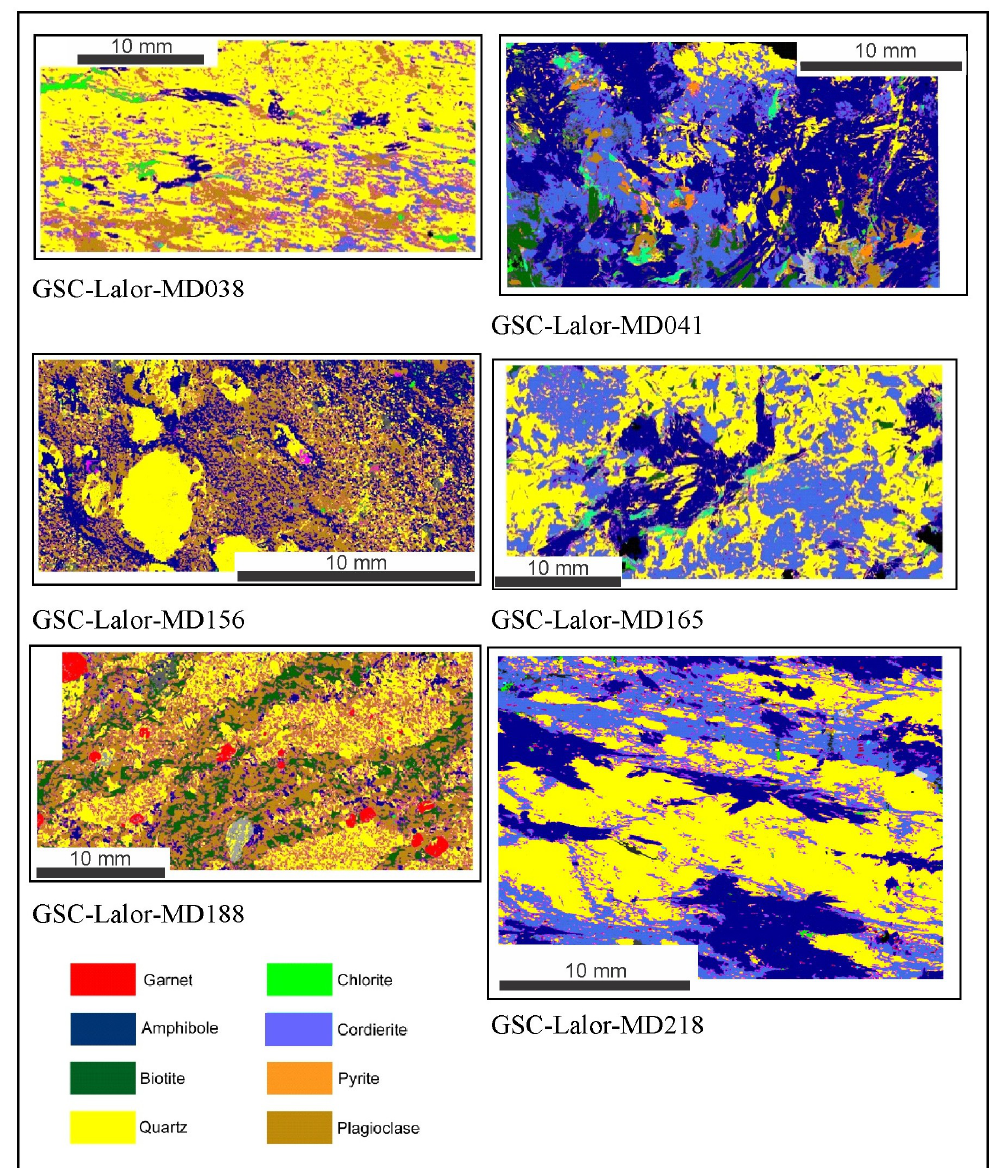
Figure 5. SEM-EDS mineral maps of six thin sections with sample identification. Table 2 Seismic rock properties of drill core samples subjected to SEM-EDS analyses .